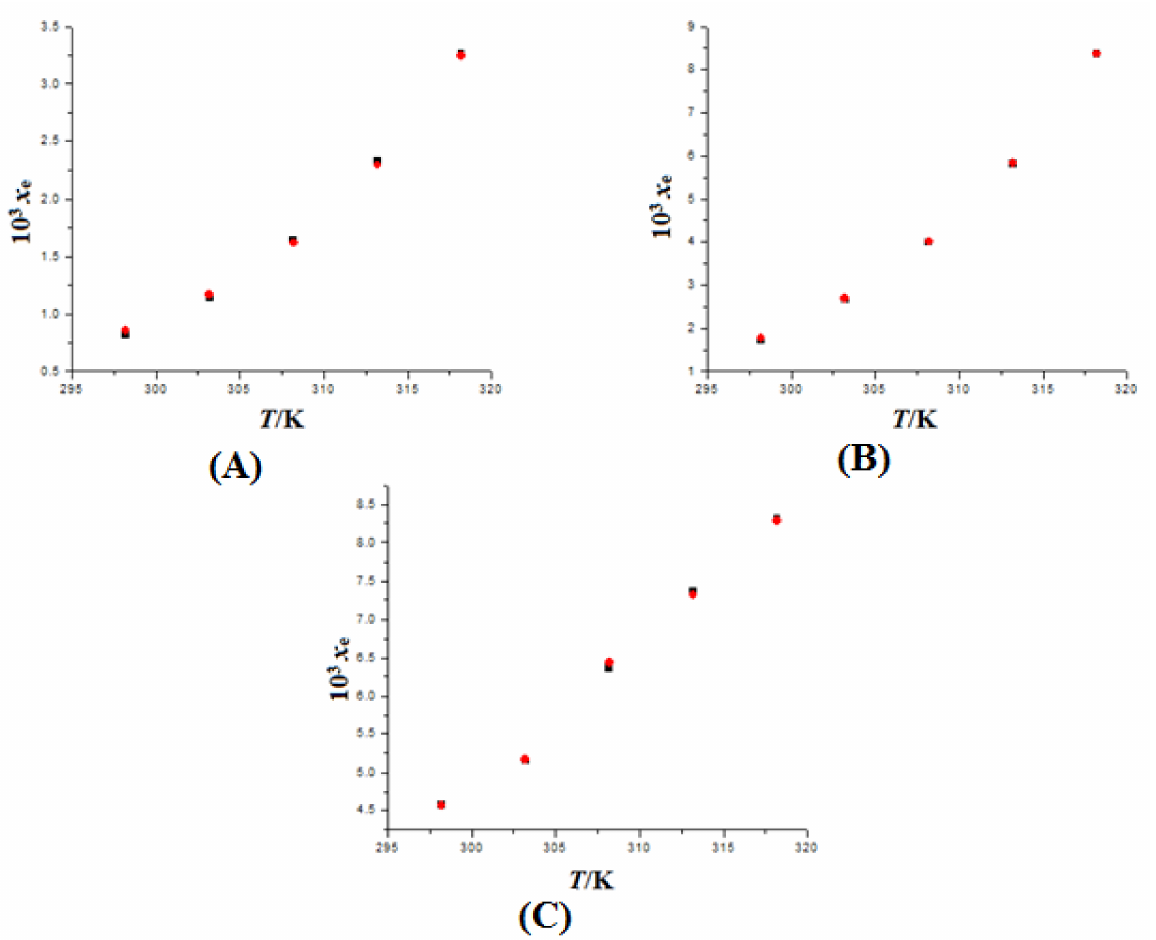
Figure 5. Comparison of mole fraction solubility values of FBX in ( A ) MeOH, ( B ) EtOH, and ( C ) EA with literature values at 298.2–318.2 K; the symbol indicates the experimental mole fraction solubilities of FBX in ( A ) MeOH, ( B ) EtOH, and ( C ) EA and the symbol indicates the literature solubilities of FBX in ( A ) MeOH, ( B ) EtOH, and ( C ) EA taken from reference